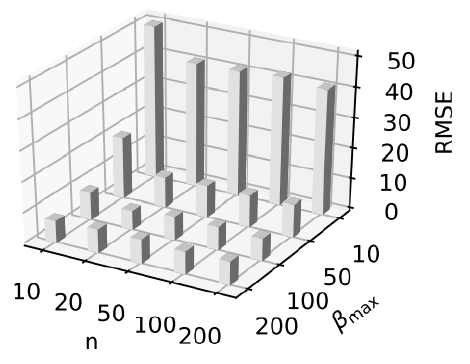
Figure 6. Sensitivity analysis using grid − search .